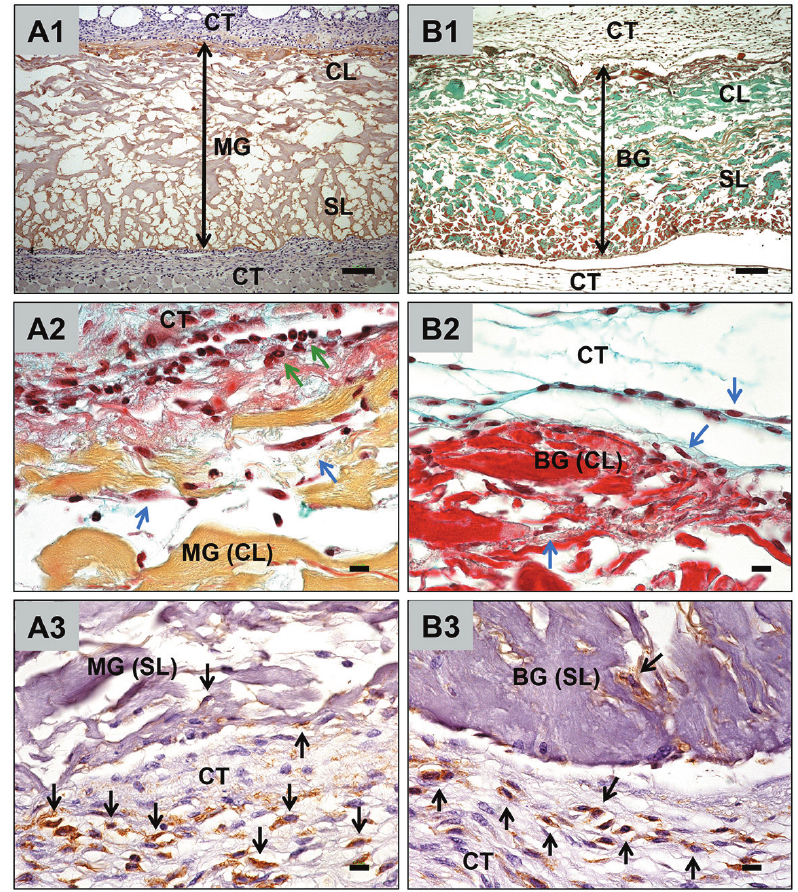
Figure 5- Cellular interactions with the materials within the subcutaneous connective tissue (CT) of CD-1 mice. A1-3 show the tissue reactions to the Mucograft (MG) matrix, B1–3 show the tissue reaction to the BioGide (BG) membrane. Magnifications: A1 and B1 x100; (scale bar=100 µm); A2-3 and B2-3 x600; (scale bar=10 µm). CL=compact layer, SL=spongy layer. Blue arrows indicate fibroblasts (A2, B2), green arrows indicate granulocytes (A2), black arrows indicate macrophages (A3, B3)